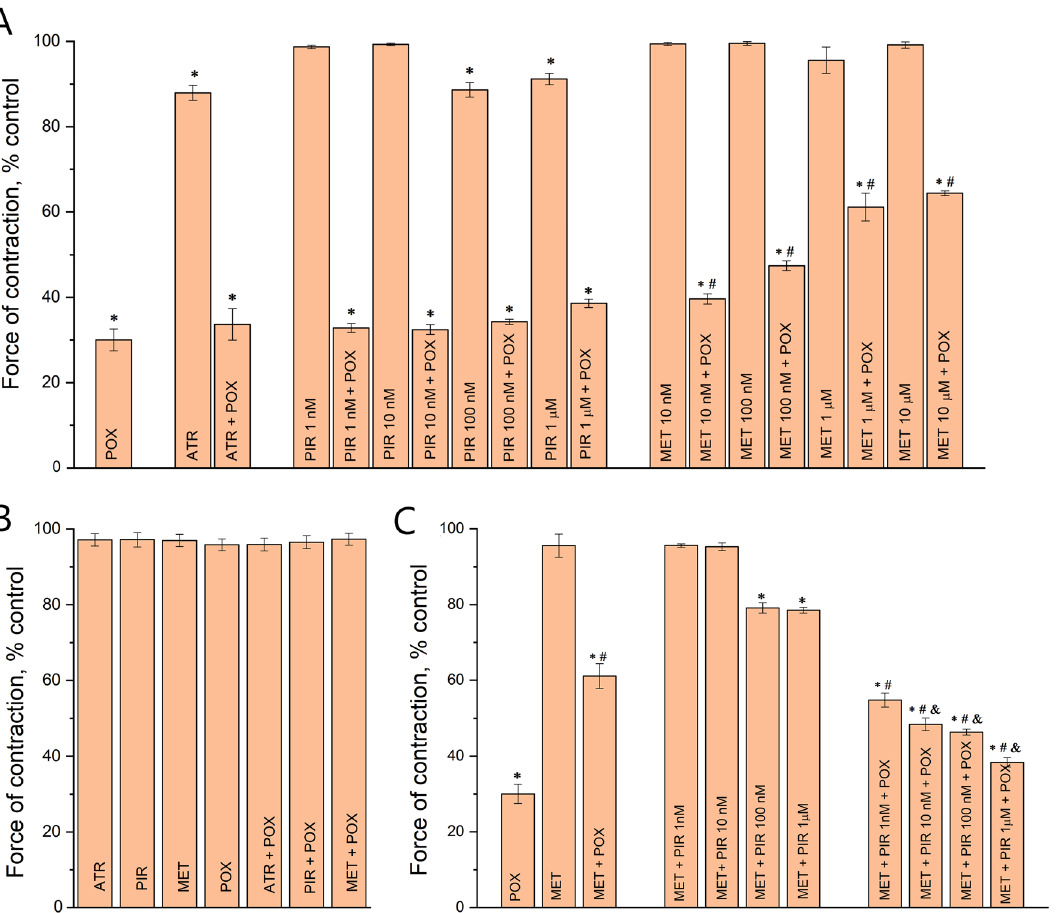
Figure 2. Relative changes in the force of diaphragm muscle contraction: ( A ) The mean force of diaphragm muscle contraction in presence of 0.5 μM paraoxon (POX), 1 µM atropine (ATR), 10 nM–10 µM methoctramine (MET) and 1 nM–1 µM pirenzepine (PIR). ( B ) Direct stimulation of diaphragm muscle in presence of 0.5 μM paraoxon (POX), 1 µM atropine (ATR), 1 µM methoctramine (MET) and 100 nM pirenzepine (PIR), when synaptic transmission was blocked by D-tubocurarine (1 µM). ( C ) Relative changes in the force of diaphragm muscle contraction in the presence of 1 µM methoctramine (MET) and after the subsequent application of pirenzepine (PIR) in concentrations of 1 nM–1 µM and 0.5 μM paraoxon (POX). The amplitude of muscle contractions in the control was taken as 100%. Data are expressed as the mean ± SEM. * p < 0.05 compared to contractions of intact control muscles. # p < 0.05 compared to contractions in the presence of paraoxon. & p < 0.05 compared to contractions in the presence of methoctramine during nerve stimulation. Statistical analysis was performed using the Mann–Whitney